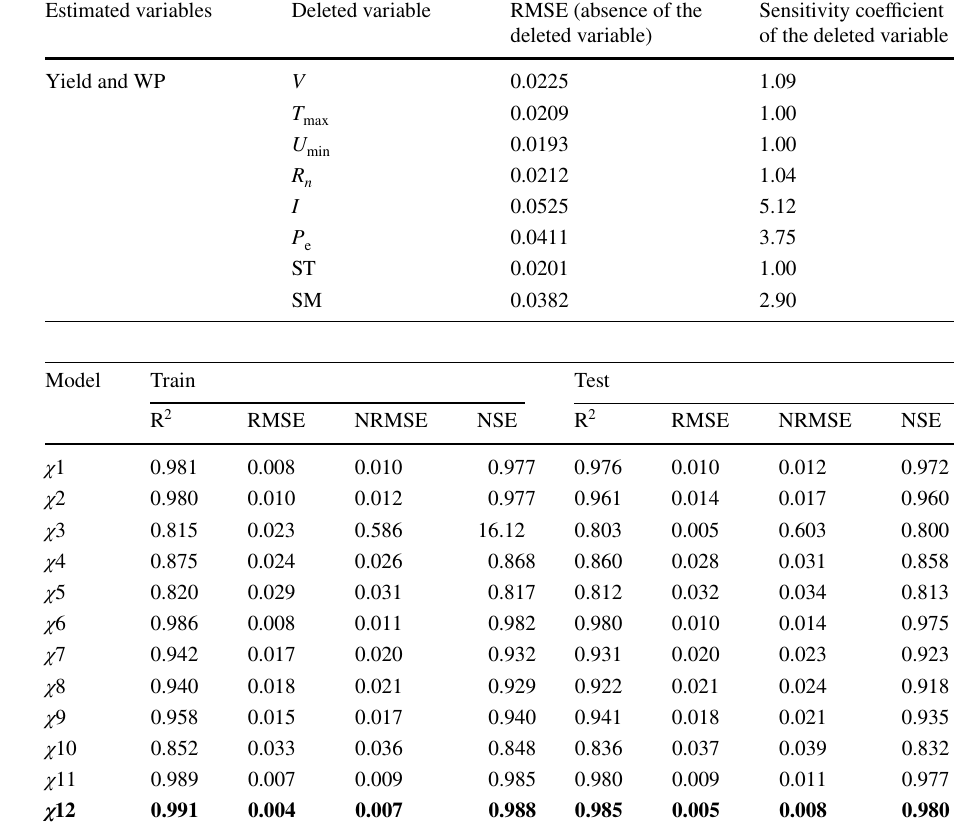
Table 7 Sensitivity analysis results for wheat yield and WP estimation